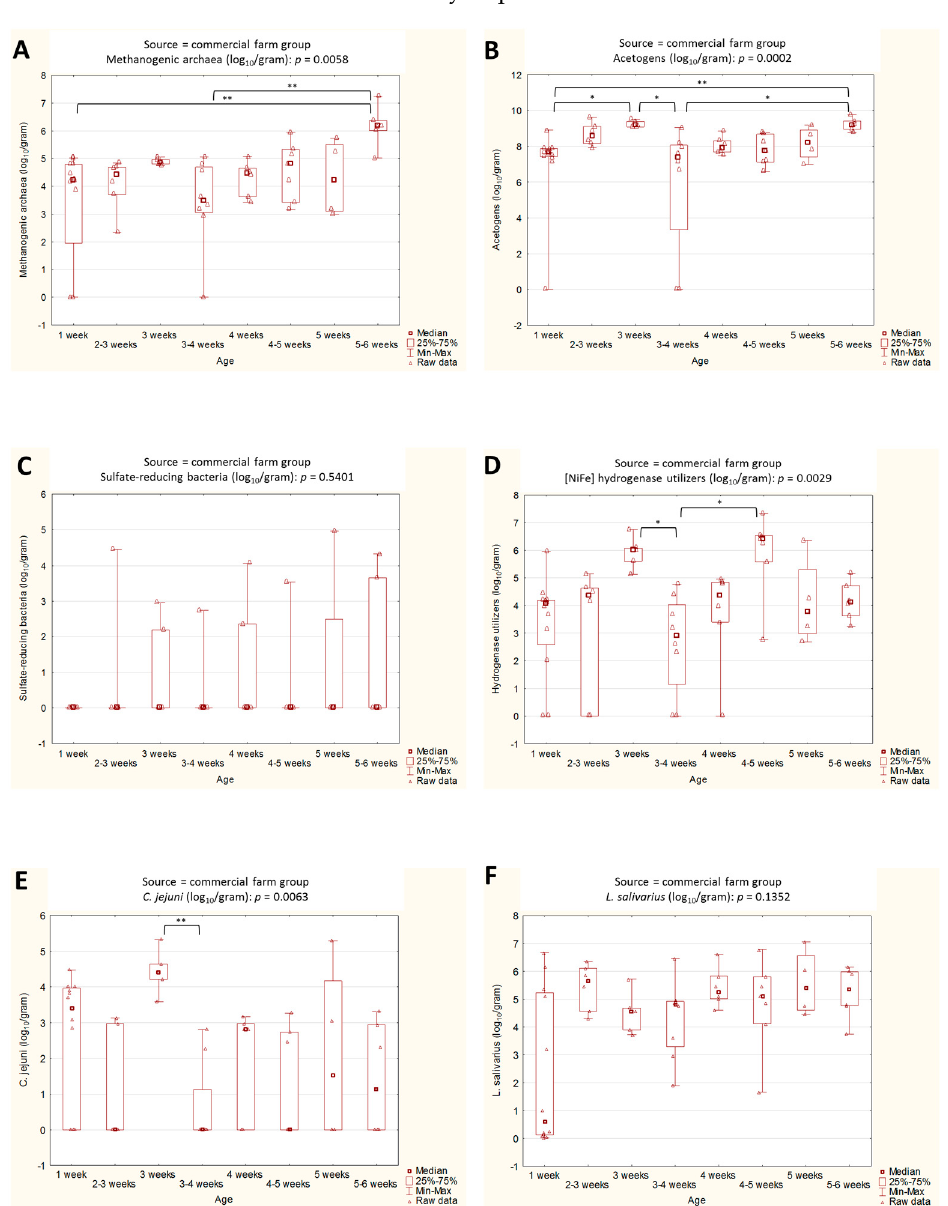
Figure 3. ( A – F ). Box plots representing the abundance of selected microbial groups across age groups in the commercial chickens. Statistical significance among the age groups is marked by asterisks. Values of * p < 0.05, and ** p < 0.01 were regarded as significant. The non-significant results remained unmarked.